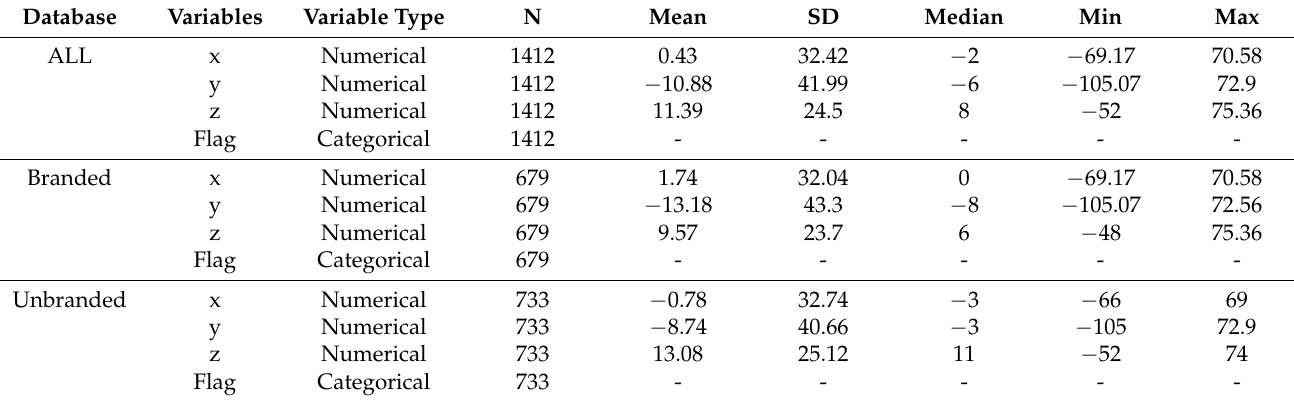
Figure 3. Explanations of the data structure. ( A ) Initial data structure. ( B ) Data structure after k- means clustering. ( C ) Data structure for machine learning. ( D ) Overall explanation of feature engineering.